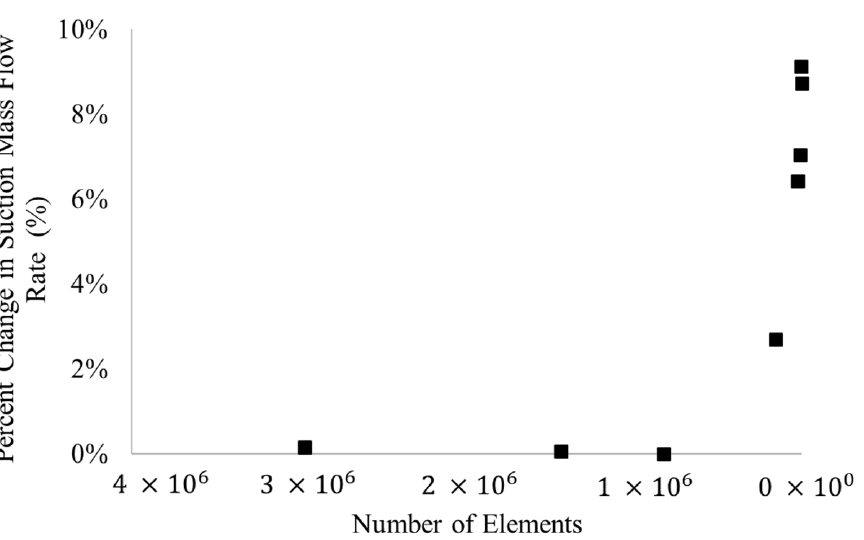
Figure 4. Mesh refinement study. Once the number of elements was increased past 828,360, there was effectively no change in the result and mesh independence was reached. Table 2. Grid refinement study and discretization